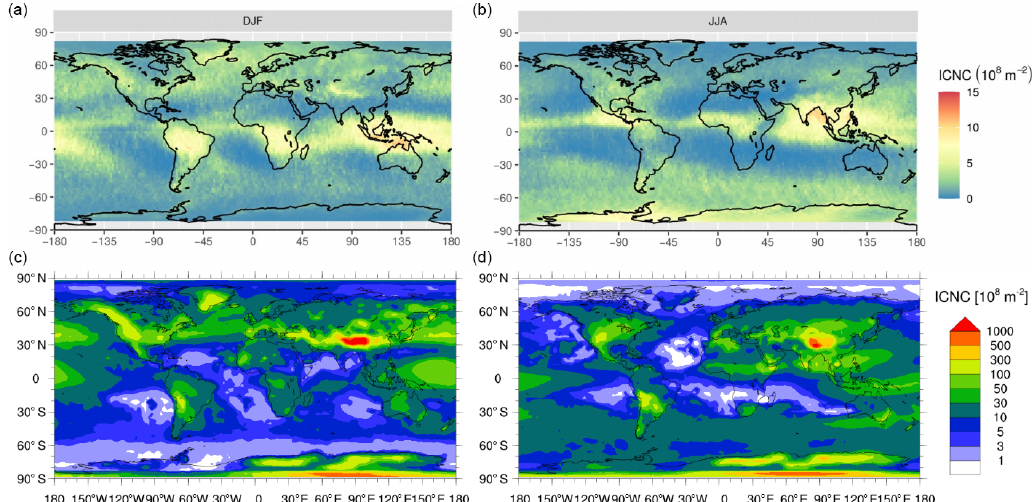
Figure 1. Mean spatial distribution of vertically integrated ICNC burden for the DJF and JJA seasons. (a, b) In-cloud ICNC burden retrieved by DARDAR-Nice (2006–2017) averaged in a 2 ◦ × 2 ◦ grid. (c, d) In-cloud ICNC burden computed by EMAC (REF 5h output greater than zero were considered in the average).